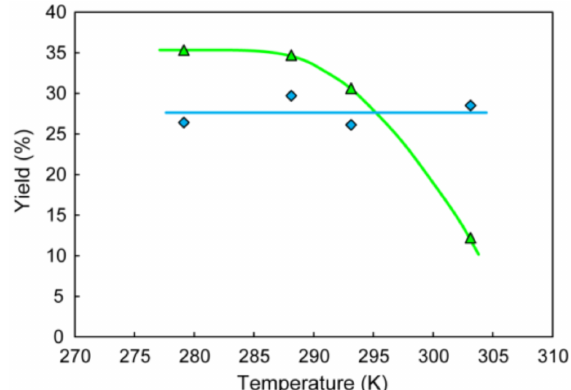
Figure 5. Yield of C 12 py-Rb-Mo 8 and C 12 py-Cs-Mo 8 hybrid crystals under various temperatures (blue diamonds: C 12 py-Rb-Mo 8 , green triangles: C 12 py-Cs-Mo 8